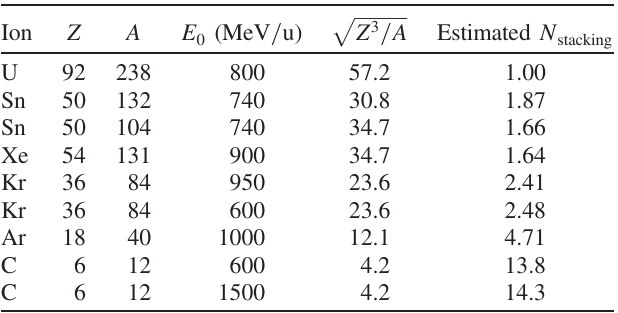
TABLE II. Estimation of stacking result on other ions. Ion